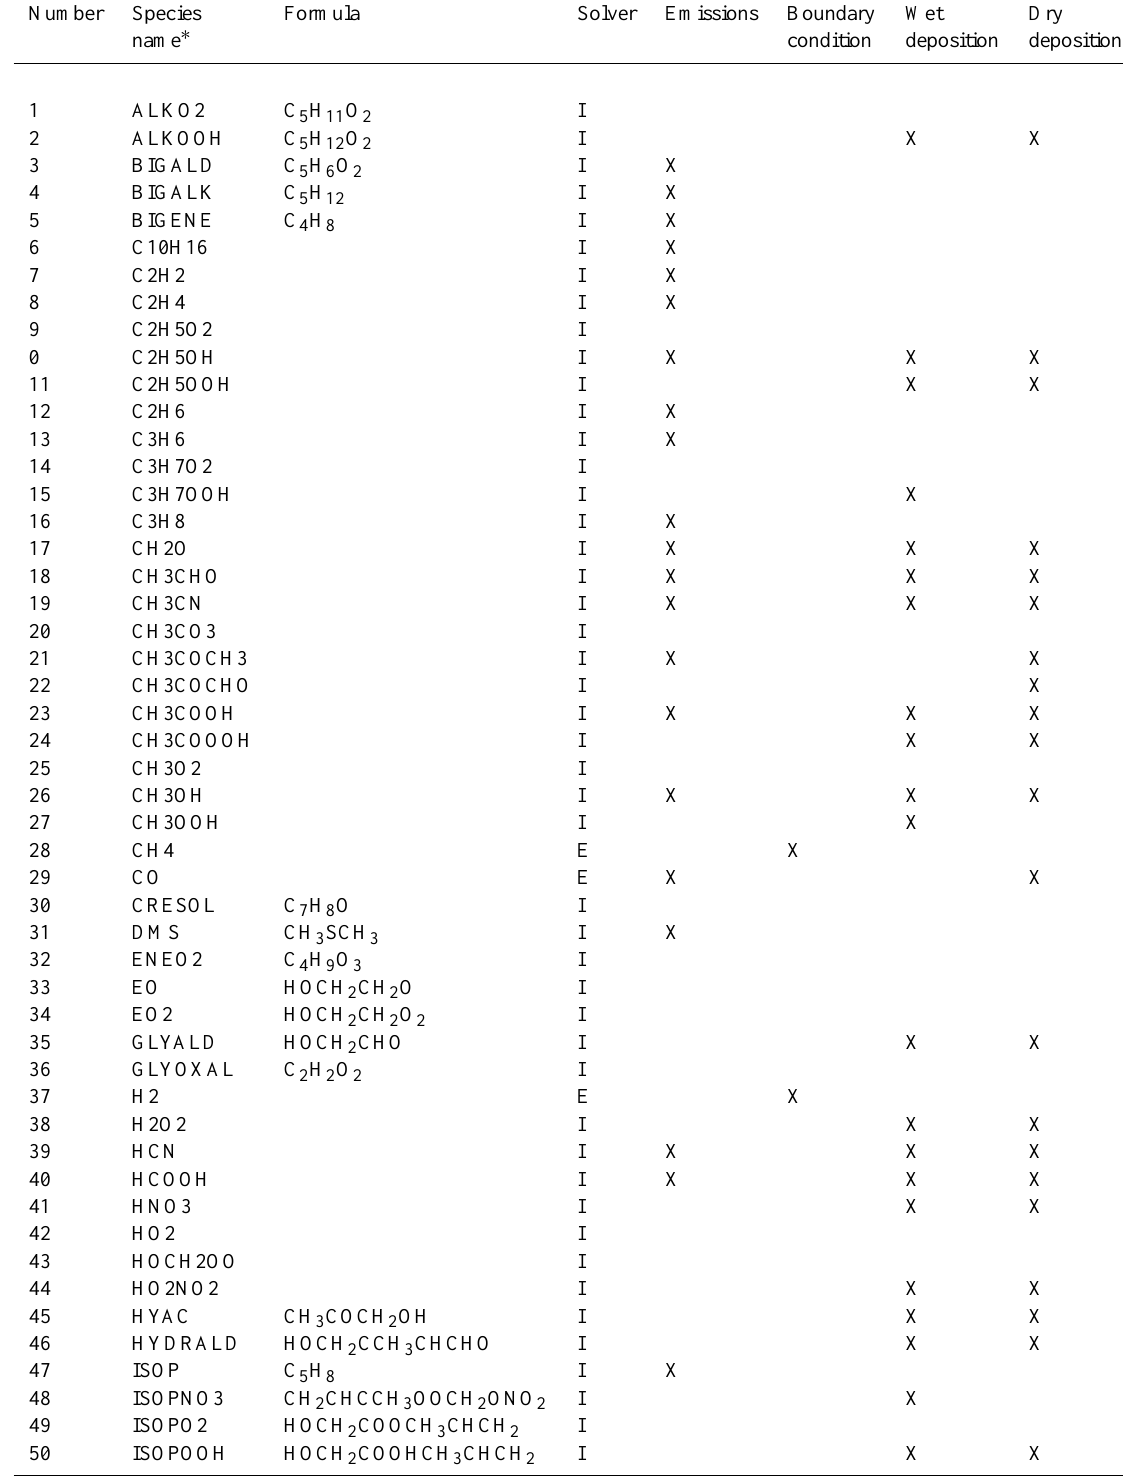
Table 3. List of species in the considered chemical mechanisms. In addition, we list the chemical solver (Explicit or Implicit), the potential use of emissions of lower-boundary conditions and of deposition processes (wet and